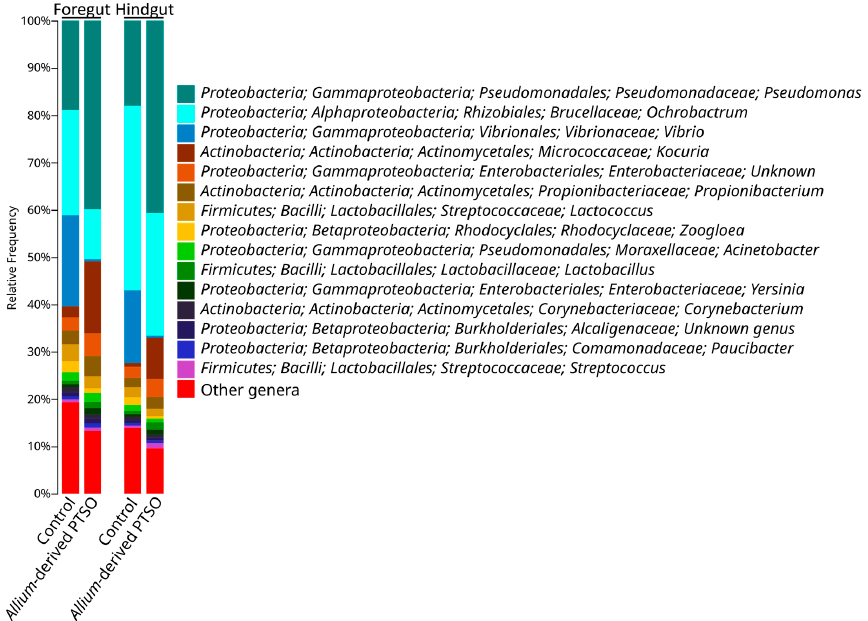
Figure 3. Microbial composition at the genus level of juvenile European seabass gut microbiota group by diet (control and Allium- derived PTSO). Genera in the legend are sorted from most abundant to lowest abundant.